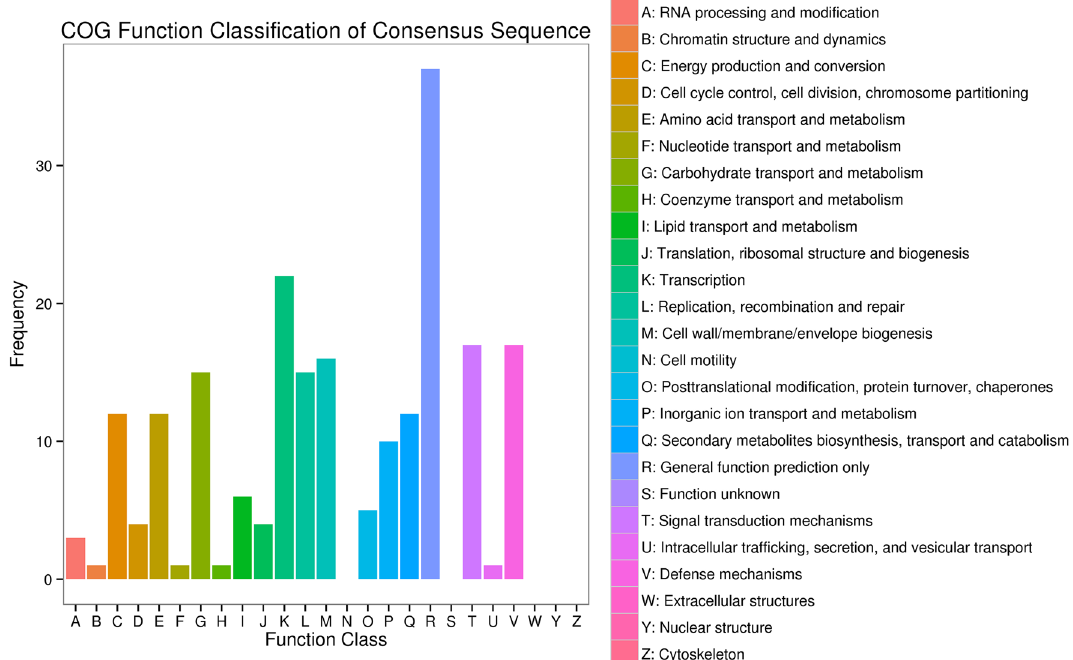
Figure 5. COG functional classification compared with the tetraploid peanut reference genome. A: RNA processing and modification; B: Chromatin structure and dynamics; C: Energy production and conversion; D: Cell cycle control, cell division, chromosome partitioning: E: Amino acid transport and metabolism; F: Nucleotide transport and metabolism; G: Carbohydrate transport and metabolism; H: Coenzyme transport and metabolism; I; Lipid transport and metabolism; J: Translation, ribosomal structure and biogenesis; K: Transcription; L: Replication, recombination and repair: M: Cell wall/membrane/envelope biogenesis; N: Cell motility; O: Posttranslational modification protein turnover, chaperones; P: Inorganic ions transport and metabolism; Q: Secondary metabolites biosynthesis, transport and catabolism; R: General functional prediction only; S: Function unknown; T: Signal transduction mechanism; U: Intracellular trafficking, secretion, and vesicular transport; V: Defense mechanisms; W: Extracellular structures; Y: nuclear structure; Z: Cytoskeleton.